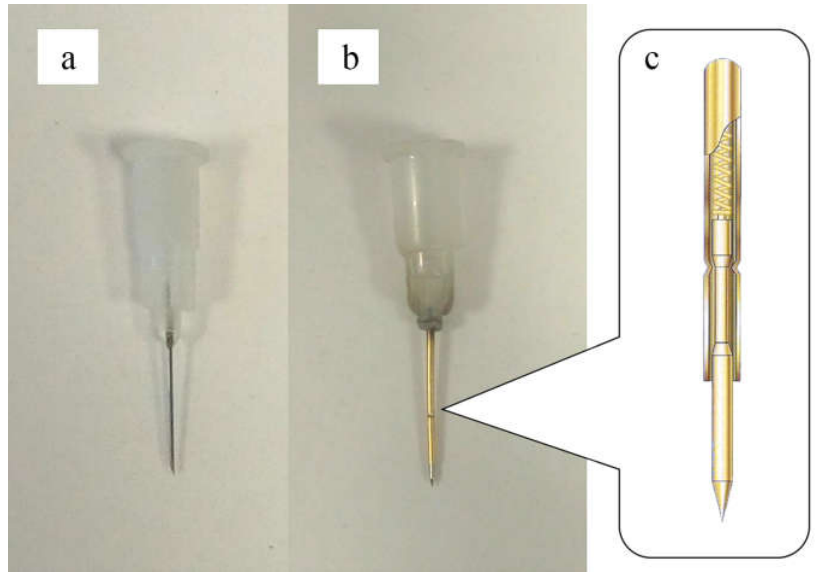
Figure 6. Modified rigid electrode: ( a )—head of an insulin syringe with a needle; ( b )—the head of an insulin syringe with a springy pressure contact fused into it; ( c )—spring clamping contact. A different contact area of the liquid eutectic electrode with the test sample can be obtained by changing the distance between the electrode and the sample. Various options for the contact area of the liquid electrode are shown in Figure 7, when studying a zinc oxide (ZnO) film. A—contact area diameter d = 40 µm; b—contact area diameter d = 80 µm; c—diameter of the contact area d = 120 µm.